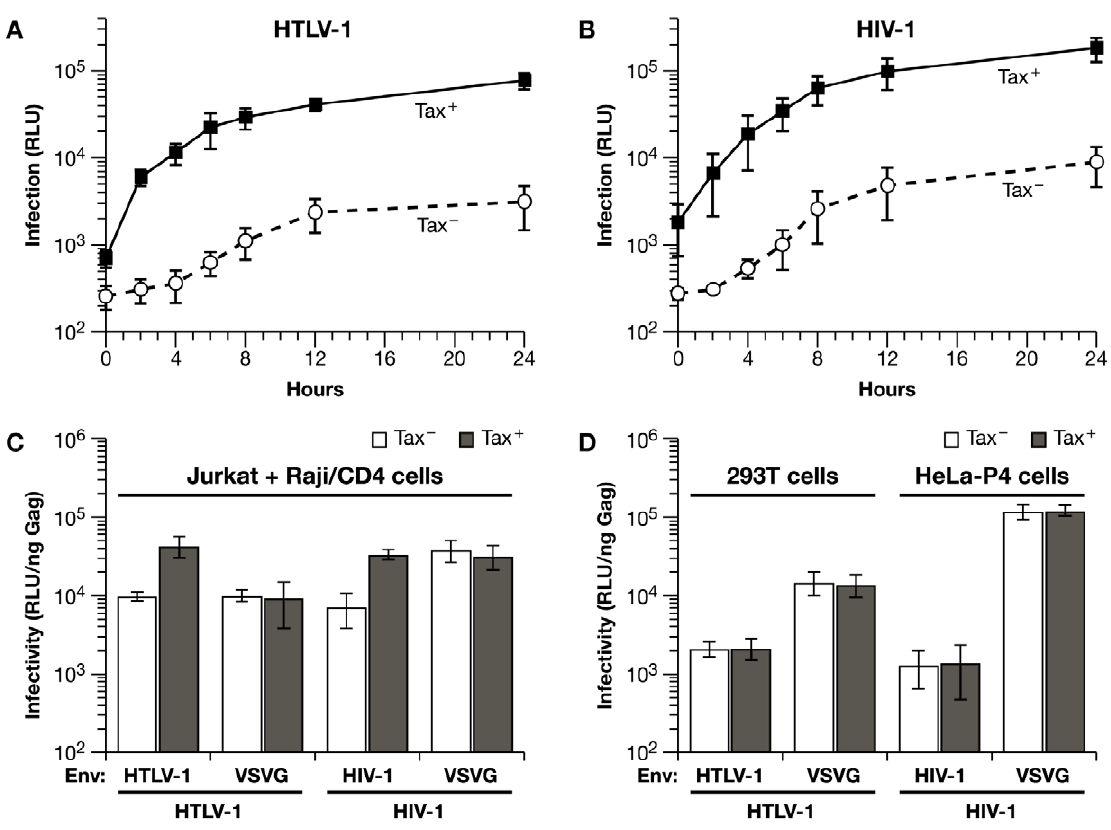
Figure 5. HTLV-1 Tax expression in Jurkat cells enhances coculture infection of Raji/CD4 cells with HIV-1 and HTLV-1 vectors. ( A ) Time course coculture infection experiments were performed as in figure 4B except that Jurkat cells were transfected with either wt (Tax + ) or mutated (Tax 2 ) HTLV-1 packaging vectors. ( B ) A coculture infection time course experiment was performed as in figure 4C except that Jurkat cells were transfected with HIV-1 vectors with either a Tax-expression vector (Tax + ) or empty vector (Tax 2 ). ( C ) HIV-1 and HTLV-1 VLPs were pseudotyped with VSV-G or their own Env and examined in Jurkat-Raji/CD4 coculture infection system with or without Tax expression. Infectivity is expressed as Luc activity (RLU) relative to the amount of Gag protein in the culture medium at 48 h. ( D ) Human 293T cells or HeLa-P4 cells were transfected with the same plasmids as in panel C. The medium was replaced the next day and the infection was allowed to develop until 48 h after transfection. Infectivity is expressed relative to the concentration of Gag in the supernatant. All results represent the mean of at least three independent experiments with standard deviations represented by error bars.